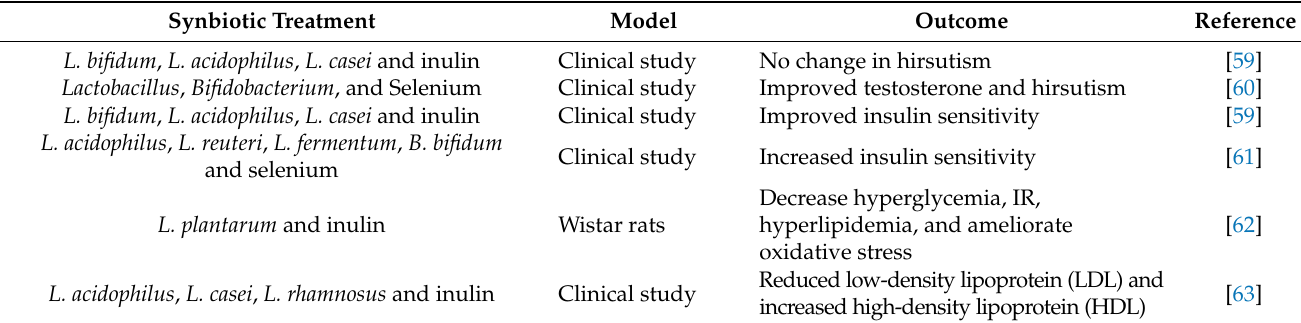
Table 2. Synbiotic treatment and outcomes related to